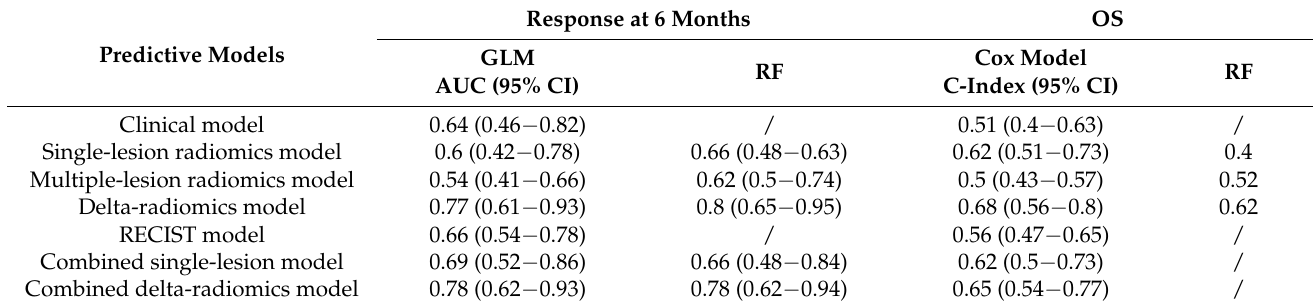
Table 3. Performances of the predictive models on the external